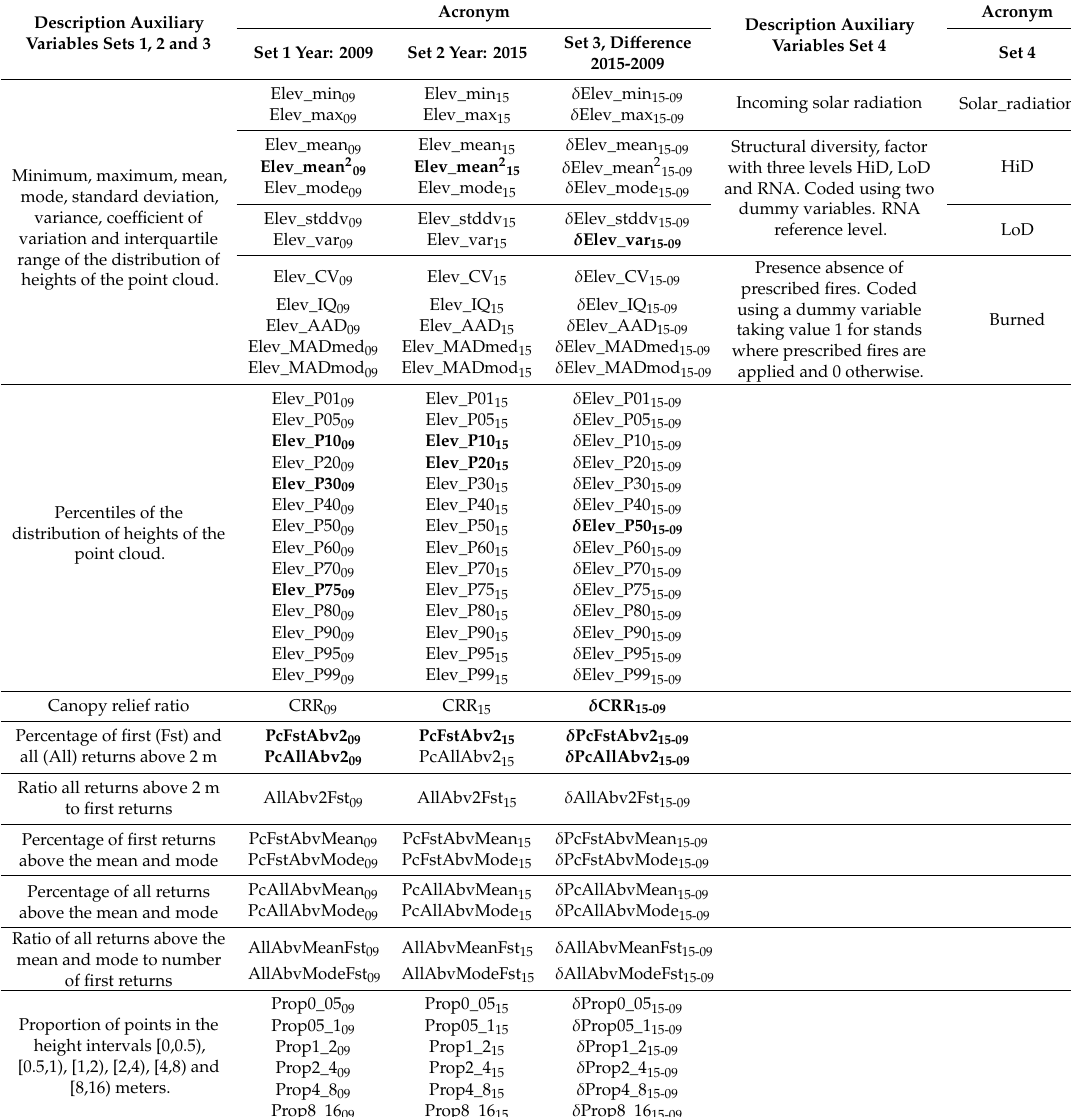
Table A1. Sets of candidate predictors used in the study. Predictors included in the models to predict structural changes are highlighted with a boldface font. HiD, LoD and RNA represent the high diversity, low diversity and research natural areas